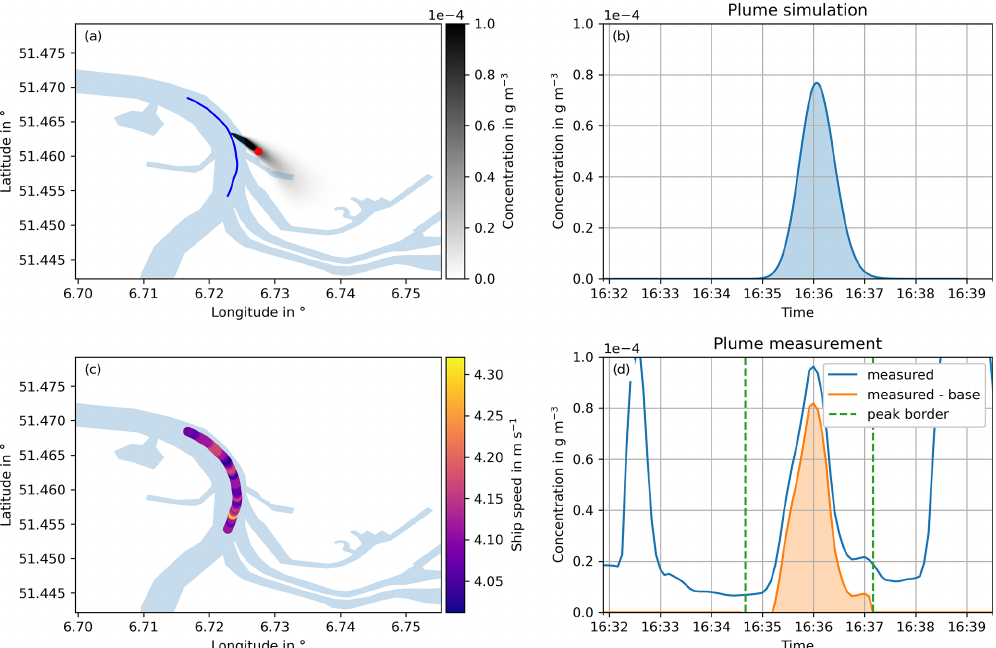
Figure 4. An example of a plume simulation for 22 August 2018 at 16:36UTC compared with the measured plume. (a) A map of the modelled plume for the time when the highest concentration has been measured. (b) A plot of the simulated concentration of NO x at the measurement site as a function of time. (c) A map showing the ship speed over ground for each time step. (d) A plot of the measured NO x concentration as a function of time at the measurement station. The blue line represents the NO x concentration, and the orange line is the background-corrected NO x concentration of the